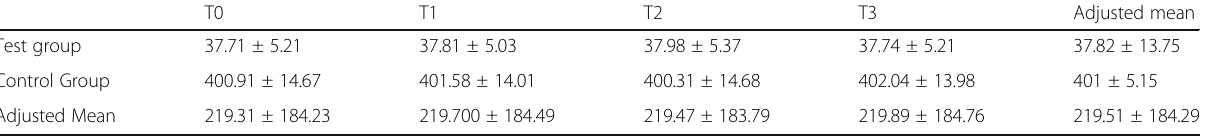
Table 1 Means, standard deviation and adjusted mean of colony count for two study groups T0 T1 T2 T3 Test